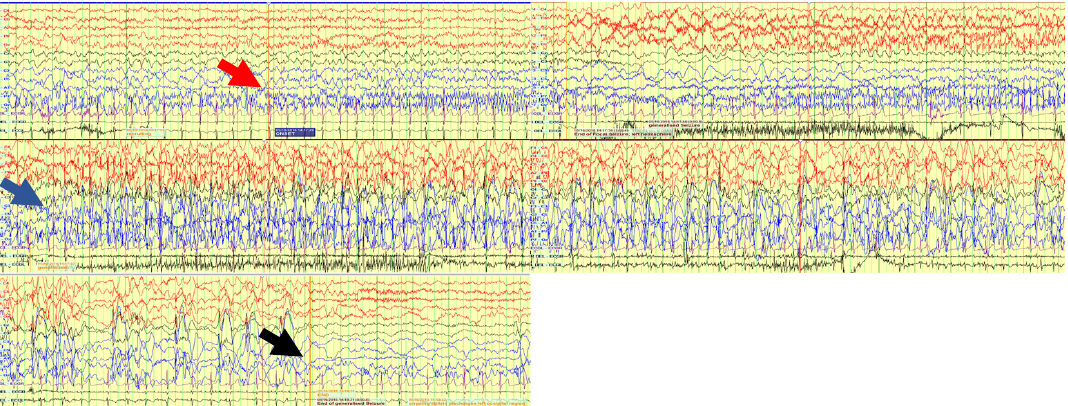
Figure 1. EEG trace during one of the 17 seizures. Red arrow: Seizure starts with fast activity over left posterior quadrant. Blue arrow: Seizure evolves to a generalized seizure involving all channels. Black arrow: seizure ends.